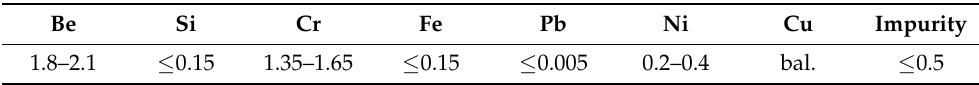
Table 1. Chemical composition of Qbe-2 beryllium bronze (wt.%).